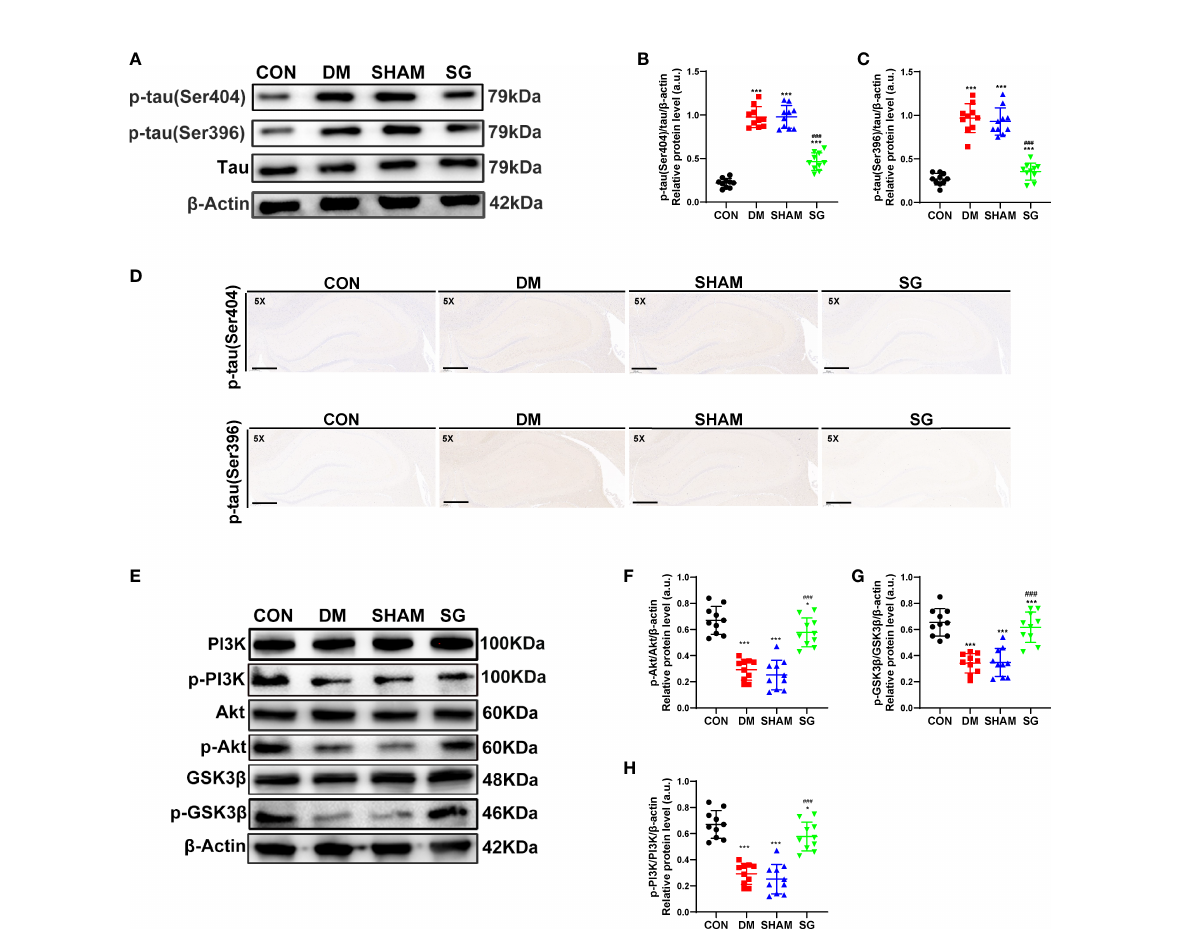
FIGURE 5 SG inhibited the phosphorylation of tau (A-D) and activated the PI3K signaling pathway (E-H) . The scale bar for D was 800 µm. Data were expressed as means ± SEM for each group (n = 10). * p < 0.05 vs. CON group, *** p < 0.001 vs. CON group; ### p < 0.001 vs. SHAM group. CON, control; DM, diabetes mellitus; SHAM, sham operation; SG, sleeve